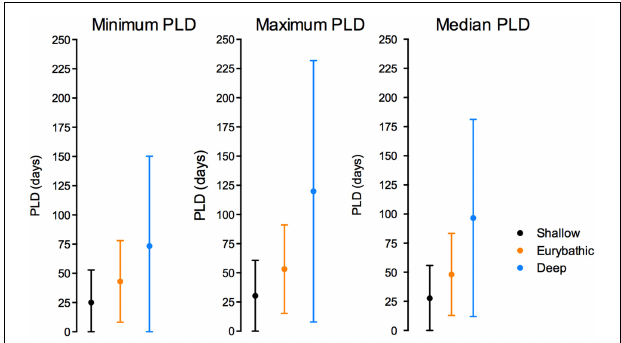
* indicates statistically significant differences. The value of 660 days determined for Sclerasterias tanneri was not included.